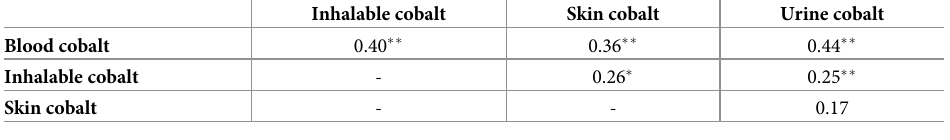
Table 6. Rank correlation coefficients between inhalable cobalt adjusted for the use of respirators and cobalt in blood, urine and on skin. Inhalable